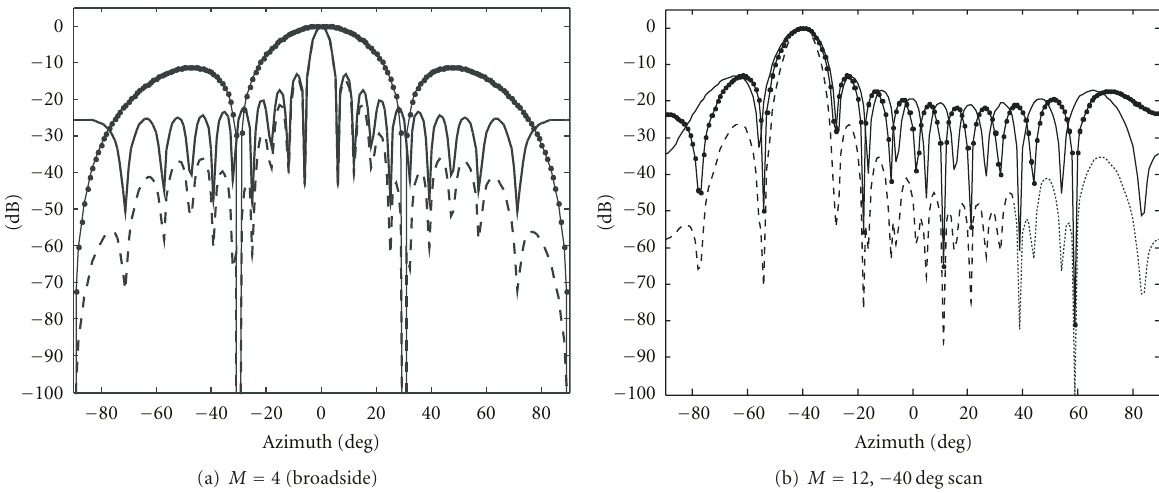
Figure 3: The two receiver patterns (azimuth only) and the associated pattern ratios. − w H A s( φ , θ ) pattern for the first transmission, -- w H B s( φ , θ ) pattern for the second transmission,and • − F ( φ , θ )) for the pattern ratio.